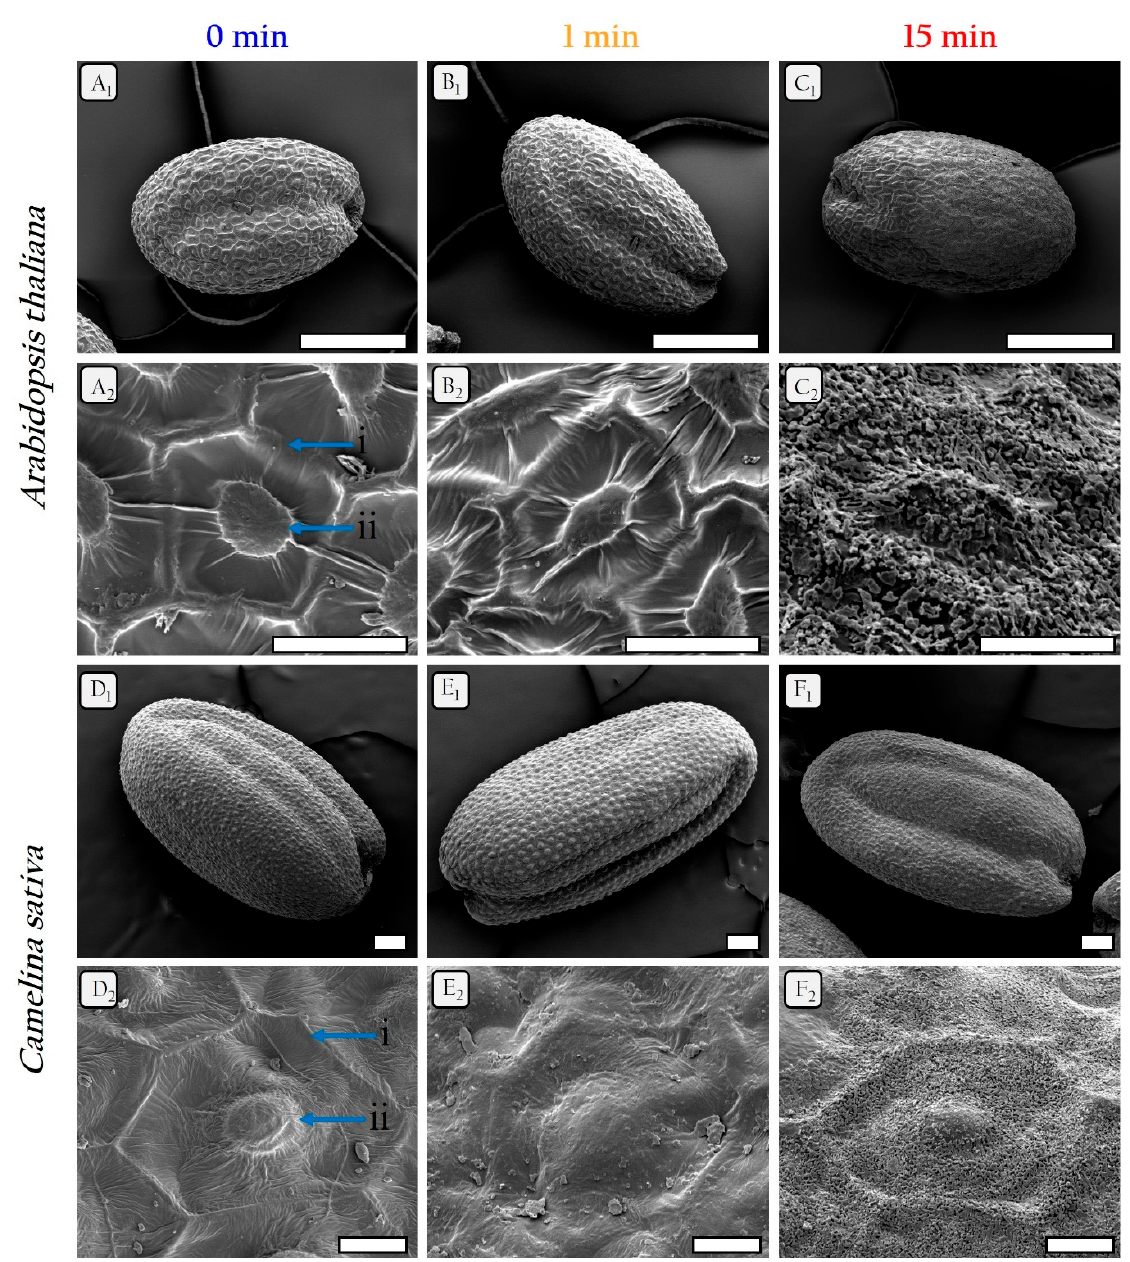
Figure 2. Scanning electron microscopy pictures of the seed surface of A. thaliana and C. sativa treated with plasma for two exposure times (1 min and 15 min) and compared to the control (0 min). The plasma treatment has an increased effect on the surface smoothing that therefore depends on the treatment time. The pictures ( A , B and C ) correspond to A. thaliana seeds. The pictures ( D , E and F ) correspond to C. sativa . In the first column, the seeds are not treated ( A , D ); In the second column, the seeds are exposed to the plasma for 1 min ( B , E ); And in the third column ( C , F ) the treatment time is 15 min. For the pictures of whole seeds (1) the scale bars are 200 µm, and for the pictures of one cell (2) the scale bars are 20 µm. i: radial cell wall, ii: columella.